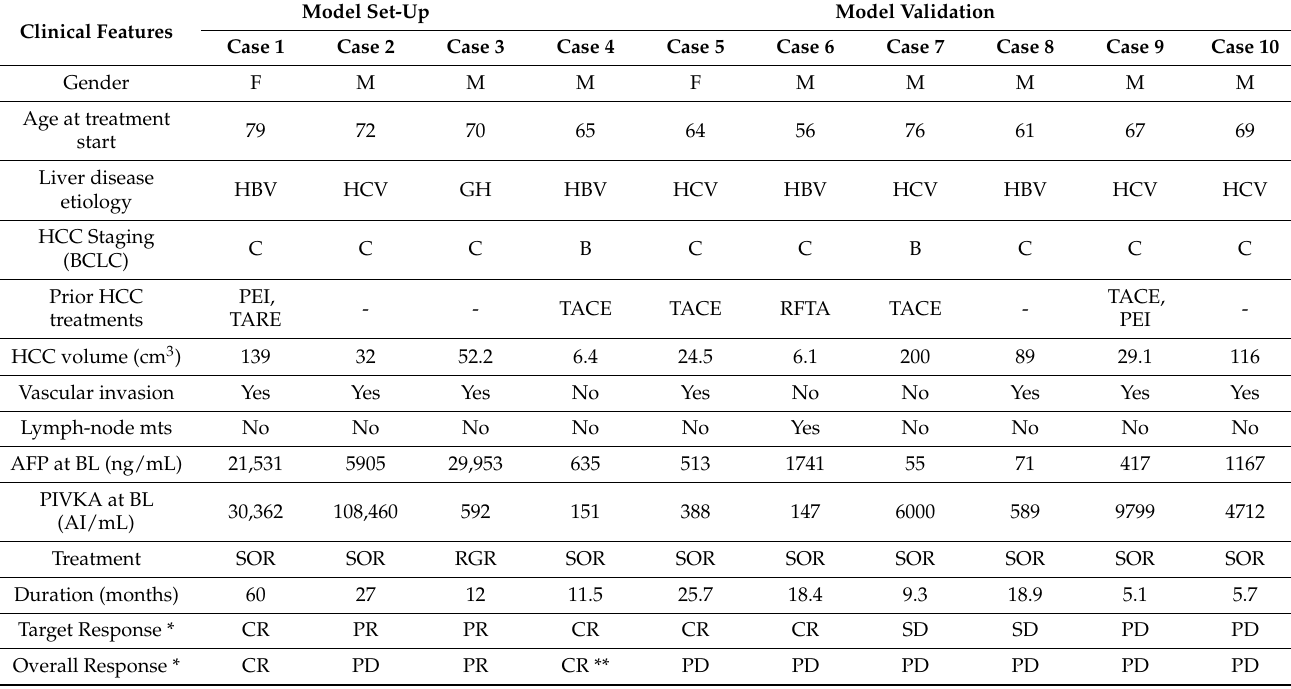
Table 1. Demographic, clinical and oncological characteristics of the patients